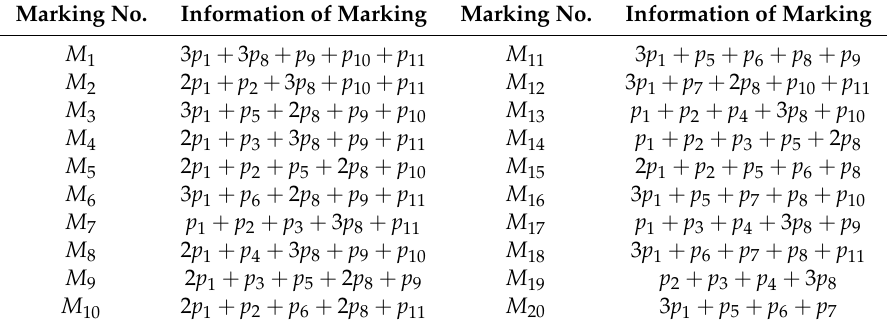
Table 1. The detailed information of all markings of Figure 3.